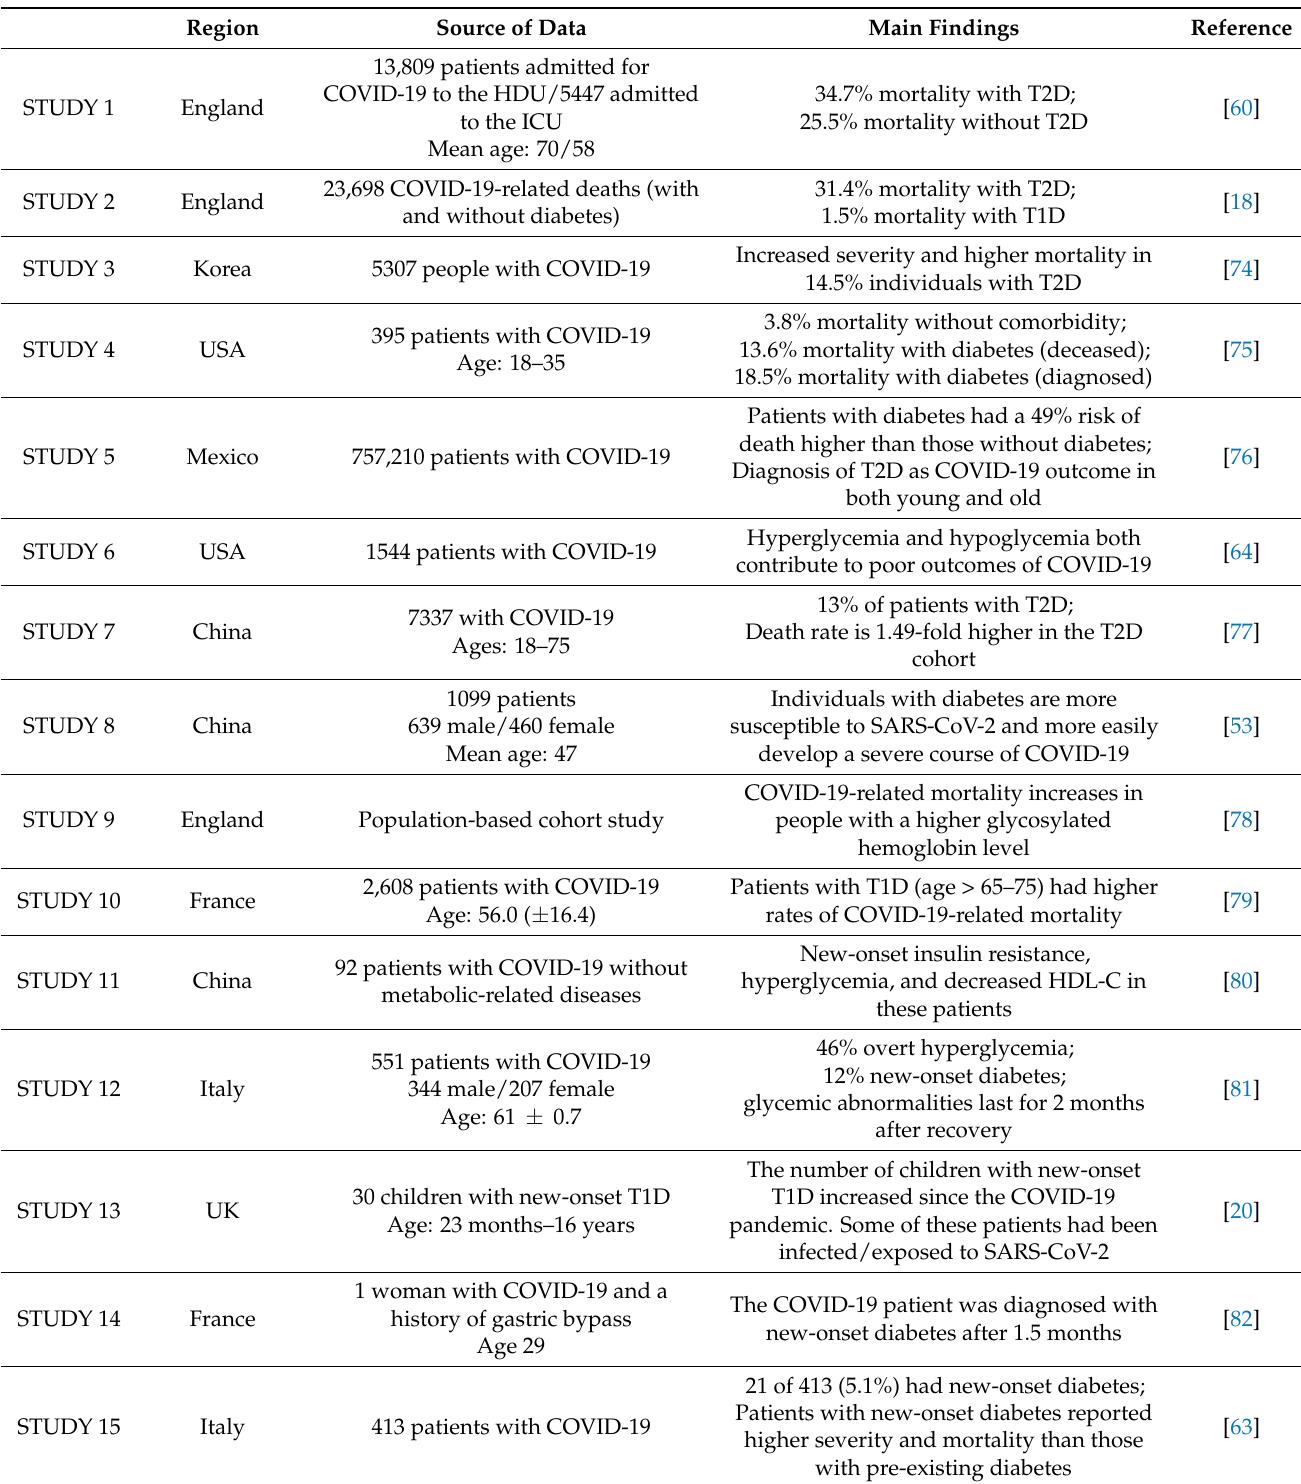
Table 1. Clinical studies showing the bidirectional relationship between glycemic control and SARS- CoV-2